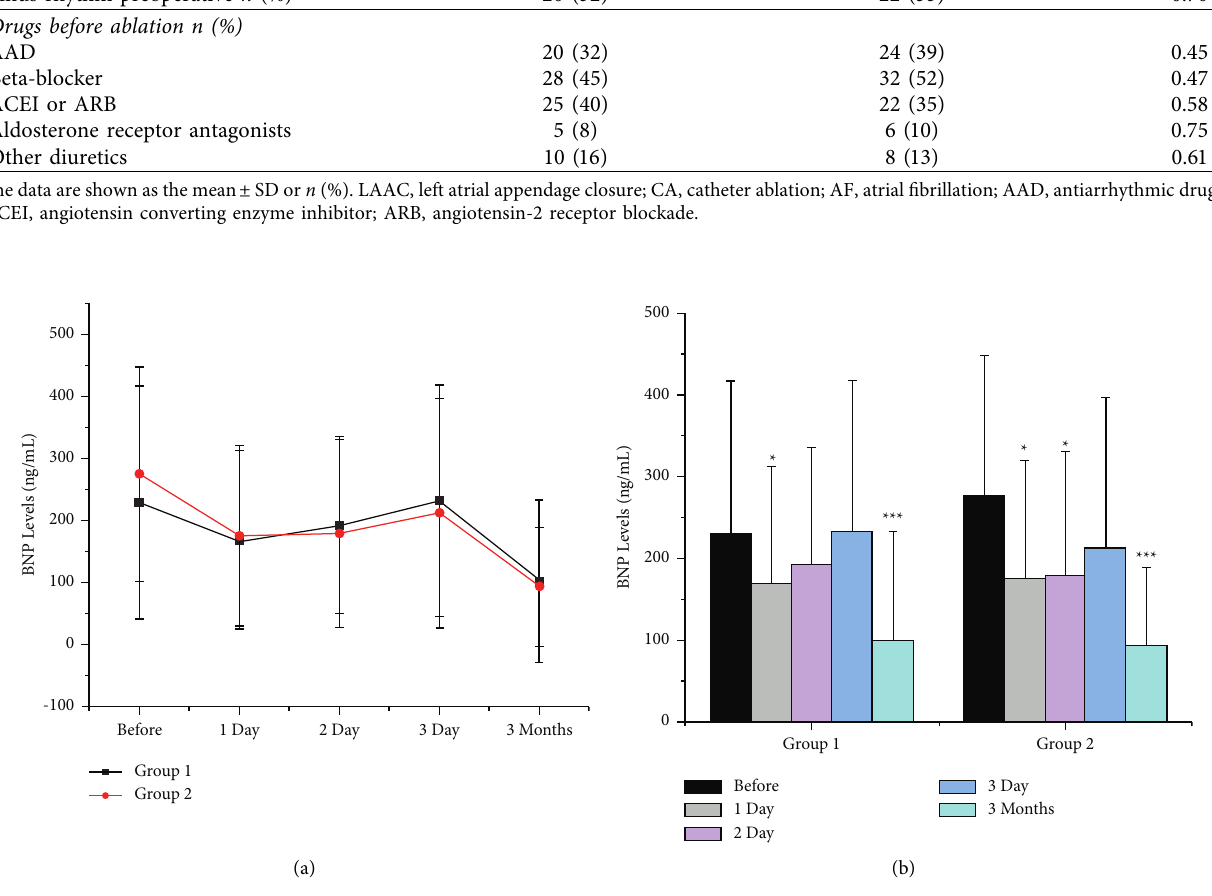
Figure 4: Changes in BNP levels over time. (a) Changes in BNP levels over time in both groups. There was no significant difference in BNP levels between the two groups. (b) The trend of changes in BNP levels in each group. Variables are expressed as the mean ± SD. BNP,